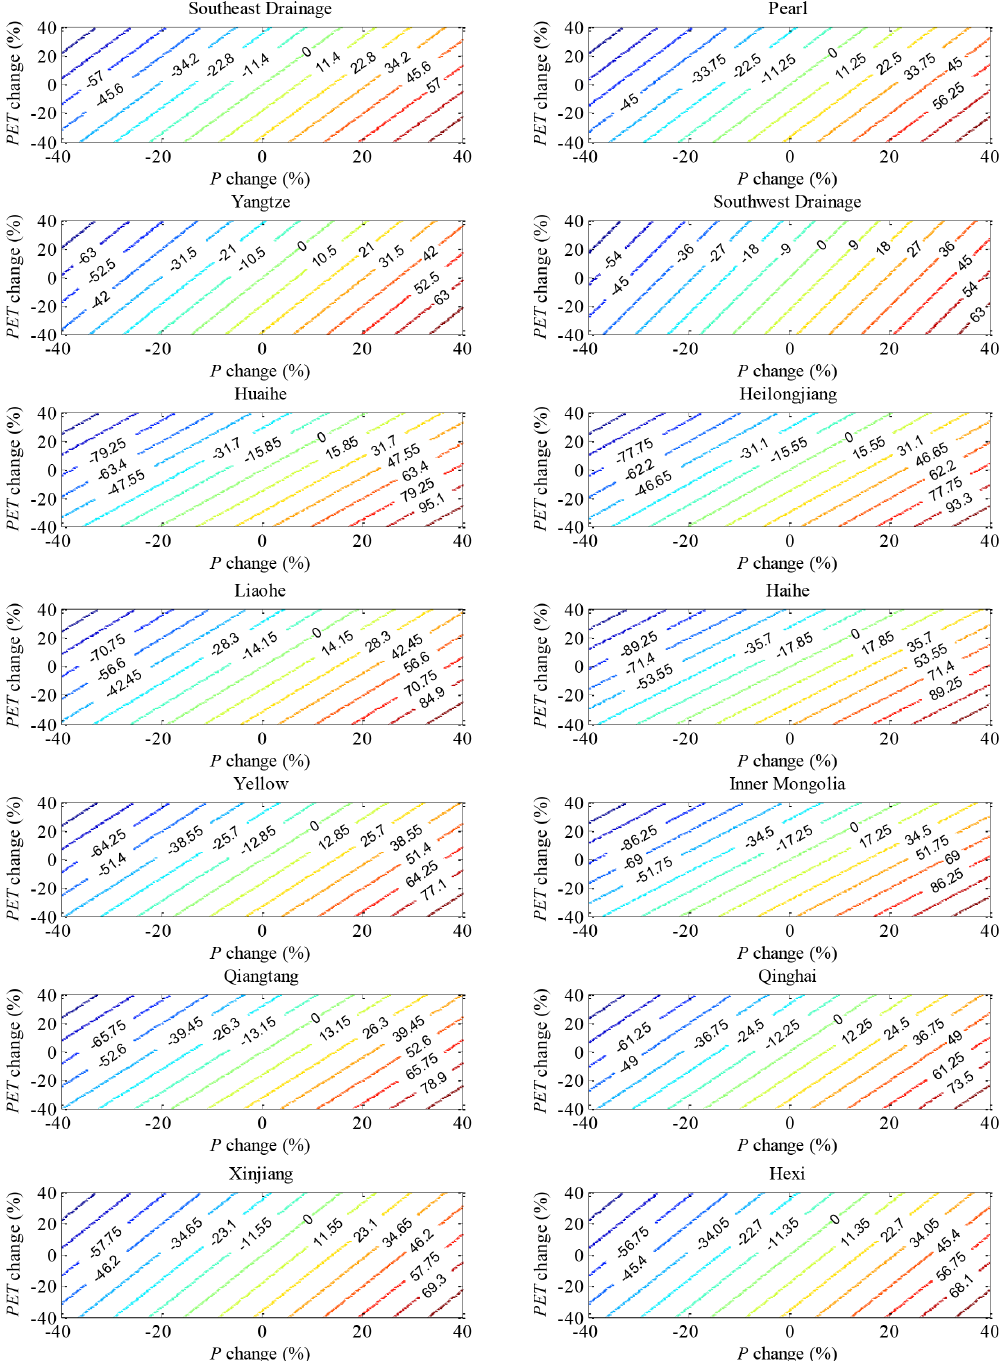
Figure 7. Contour plot of percentage R change due to the changes in P and PET for the 14 river basins. The P elasticity and PET elasticity of R are estimated based on Eq.